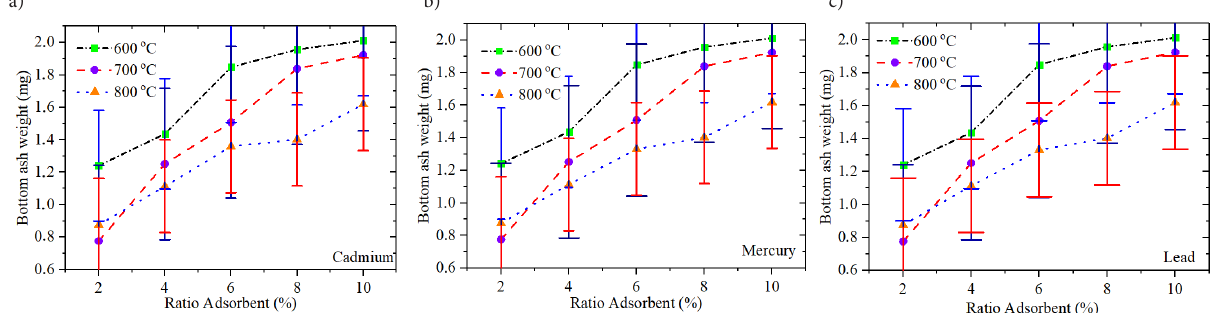
Figure 3. Remaining Cd, Hg, and Pb ash on the adsorbent ratio for different